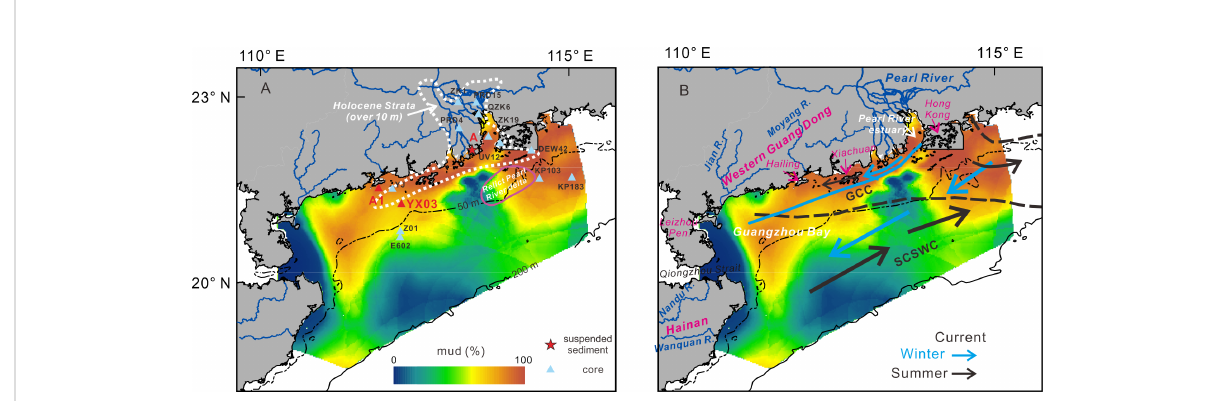
FIGURE 1 The study area and core sites: (A) location of new cores (red triangle) and some reference cores (blue triangle) in this study. Grain size data of suspended sediments from the Pearl River was measured by Zheng et al. (2017) at the station (A) Dotted lines circle the zones with thick Holocene deposits (>10 m) according to Ge et al. (2014). The relict delta of the Pearl River was mapped by Bao (1995). (B) Current systems and freshwater plumes in summer and winter on the northern shelf of South China Sea according to Ding et al. (2017) and Su (2004). GCC, Guangdong coastal current; SCSWC, South China Sea warm